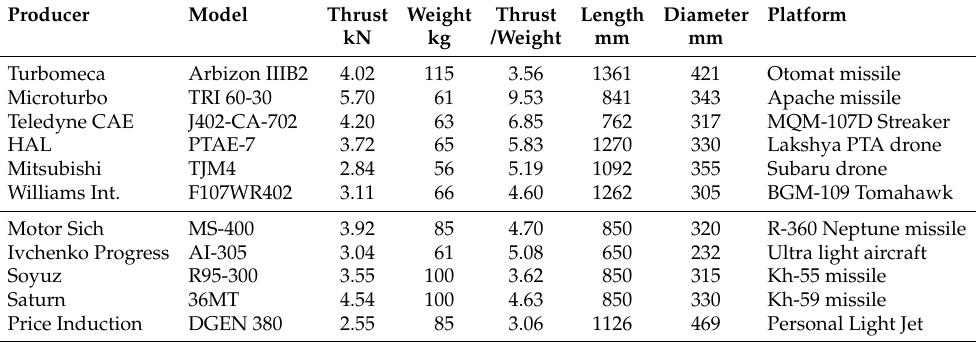
Table 1. Small gas-turbine engines. Data from minijets.org, uasresearch.org, wikipedia.org and